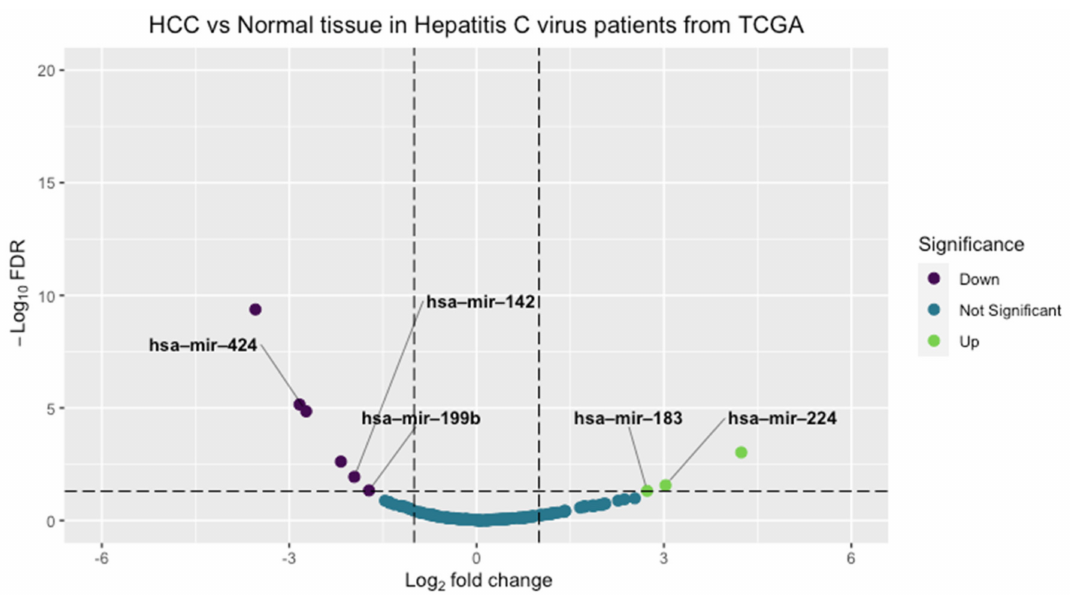
Figure 2. Volcano plot of TCGA differentially expressed miRNAs. MiRNAs colored in purple were downregulated, and those colored in green were upregulated in HCC samples compared to non- tumor tissue samples. The filtering criterion was adjusted using a log 2 fold change cutoff of 1 and FDR cutoff of 0.05. (FDR: False discovery rate, HCC: Hepatocellular carcinoma, TCGA: The cancer genome